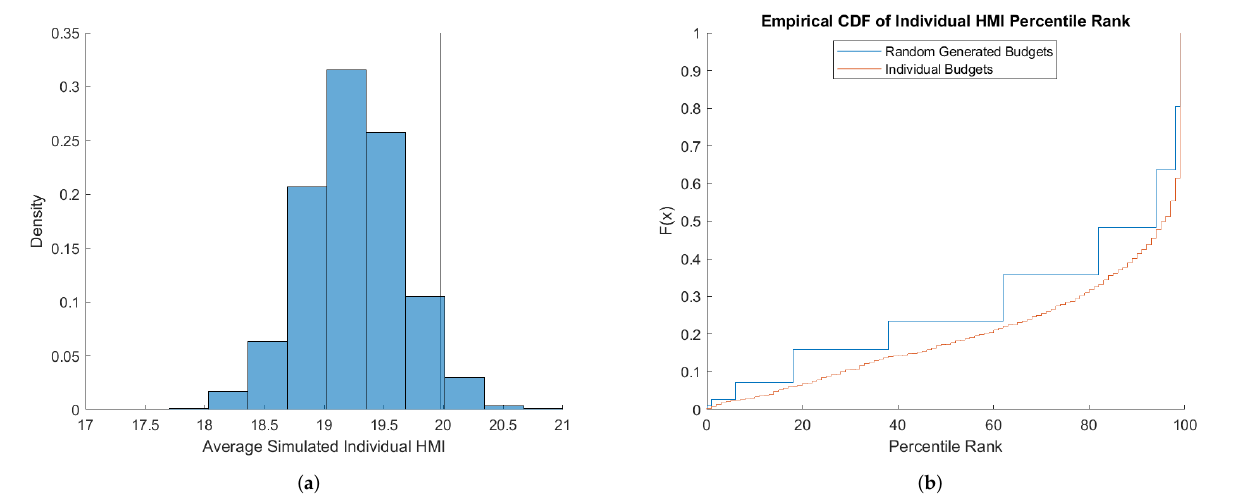
Figure 5. Simulation Results for HMI (CKMS). ( a ) Histogram, ( b ) Percentile Ranks. Correlation with Observable